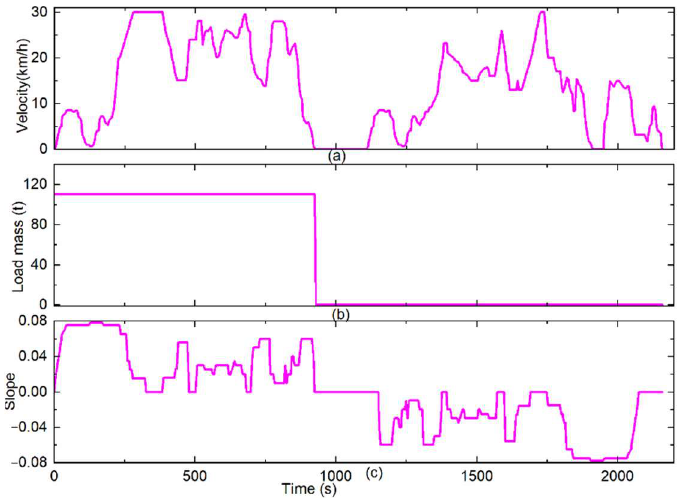
Figure 4. Typical real condition of the HMDTS. ( a ) real velocity in typical condition; ( b ) load mass in typical condition; ( c ) slope in typical condition.